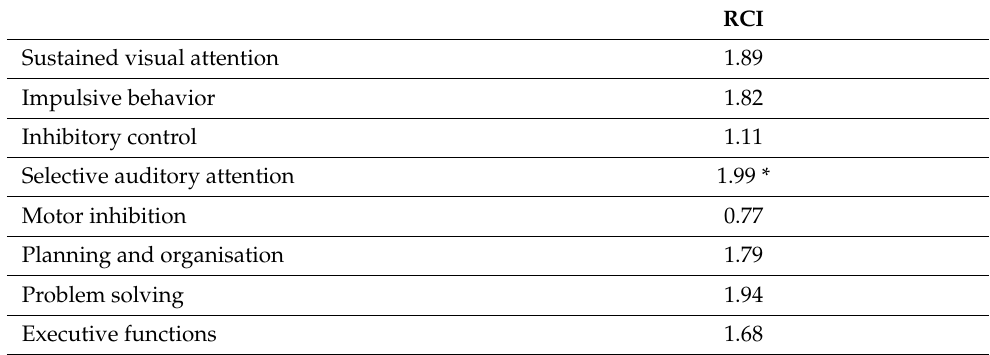
Table 12. Summary table of RCI values of BIA and TOL test